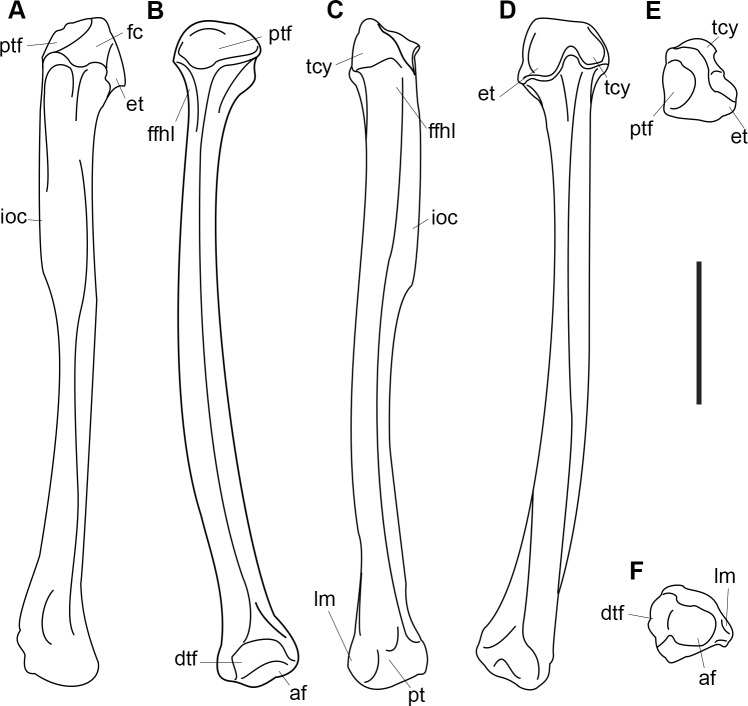
Annotated line drawing of the left fibula of Periptychus carinidens.(A) anterior view; (B) medial view; (C) posterior view; D, lateral view; (E) proximal view; (F) distal view. Abbreviations: af, astragalar facet, dtf, distal tibial facet; et, extensor digitorum longus tubercle ffhl, fossa for the flexor hallucis longus; ioc, interosseous crest; lm, lateral malleolus; tcy, tubercle for attachment of the cyamella ligament; ptf, proximal tibial facet. Scale bar: 30mm.